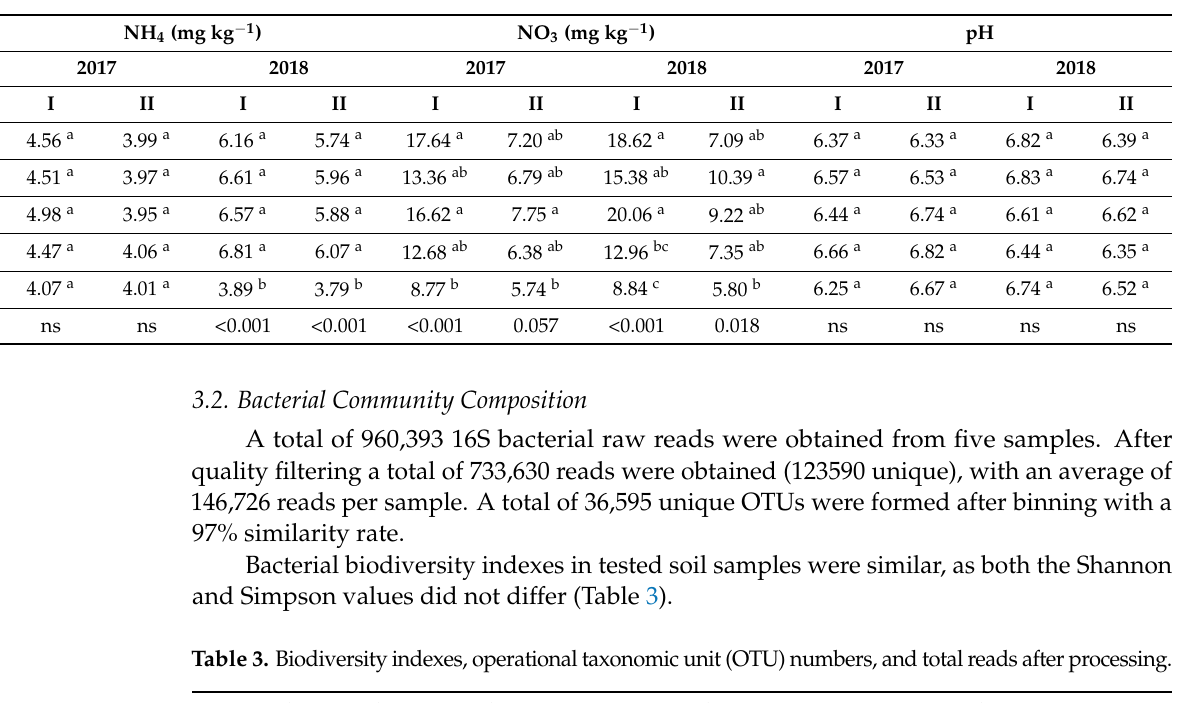
Table 2. Chemical properties of tested soil in May (I) and August (II) 2017 and 2018 ( n = 4). Different letters behind the mean values indicate significant differences (Tukey–Kramer HSD test, α < 0.05).